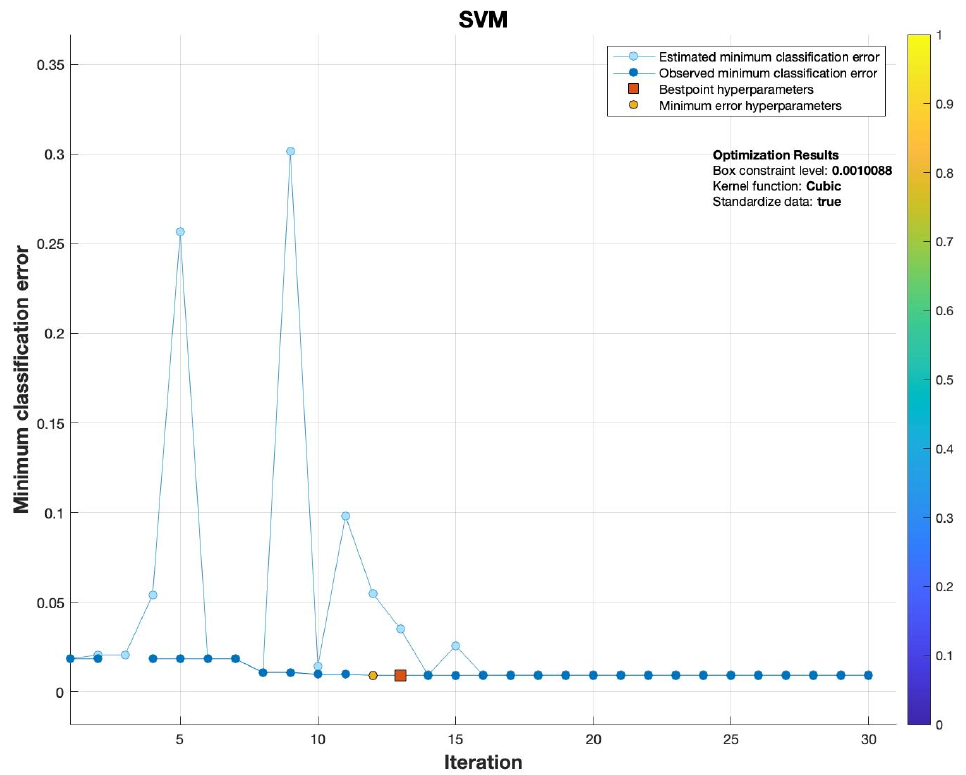
Figure 2. Training MCE of SVM for the detection of network meddling. Table 6. Performance Analysis of KNN (%) During Training Phase.